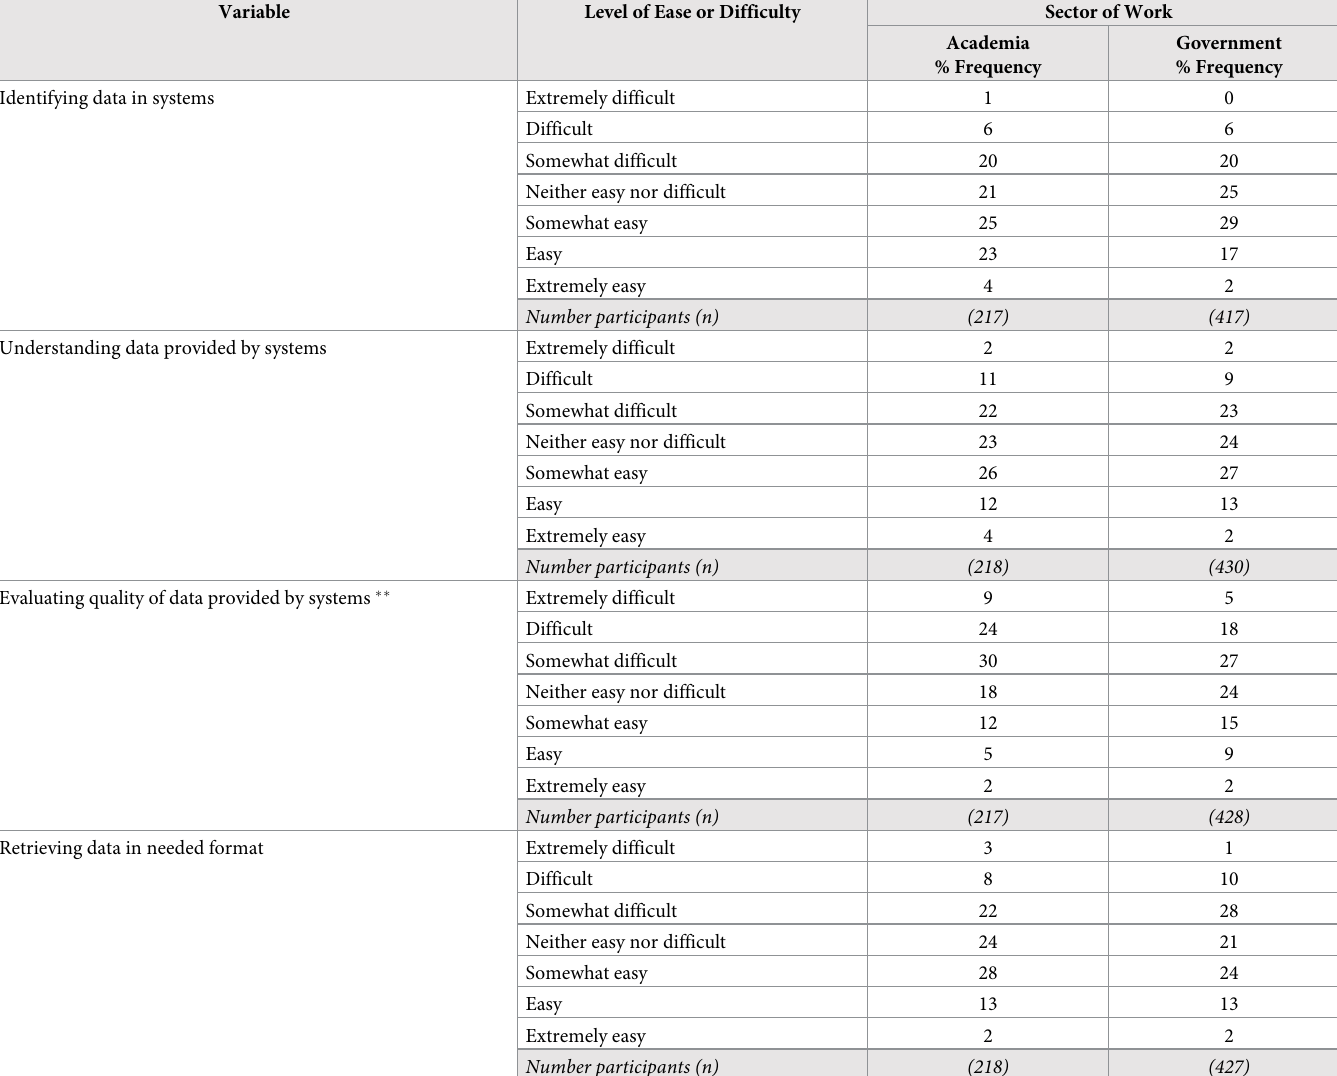
Table 13. Level of ease / difficulty of aspects related to using data from web-based species occurrence information